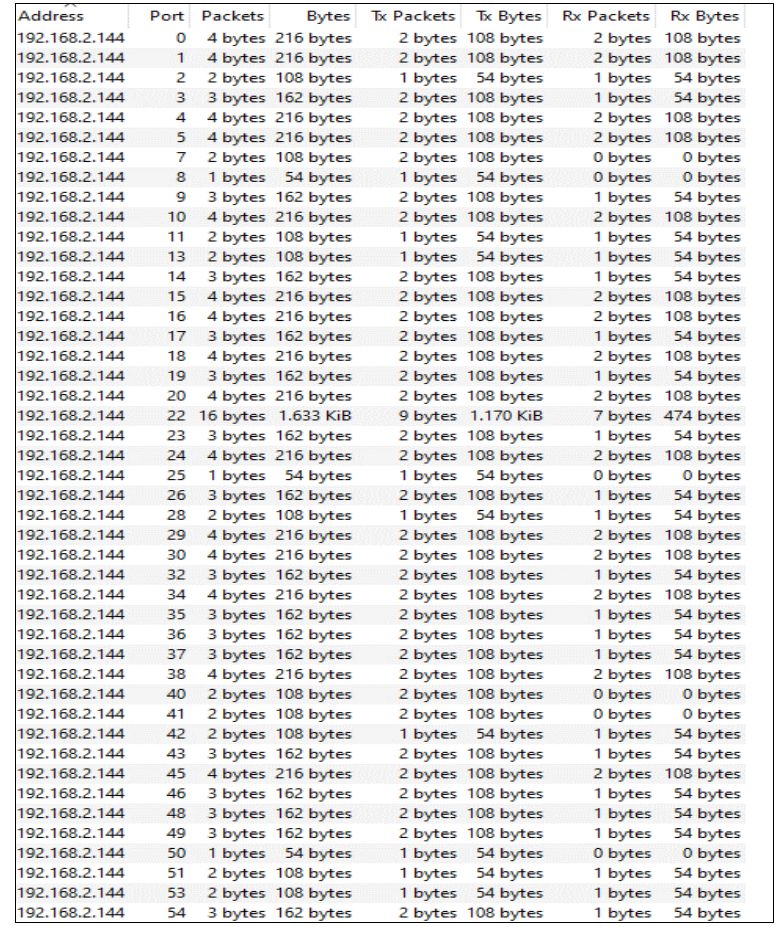
Figure 8. TCP port-based status.